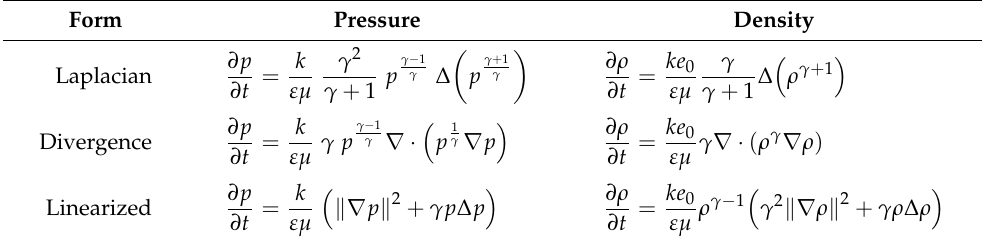
Table 1. Overview of PME formulations. Differential operators act on spatial dimensions, where ∇ u is the gradient, ∇ · (cid:126) u is the divergence, and ∆ u is the Laplacian. Form